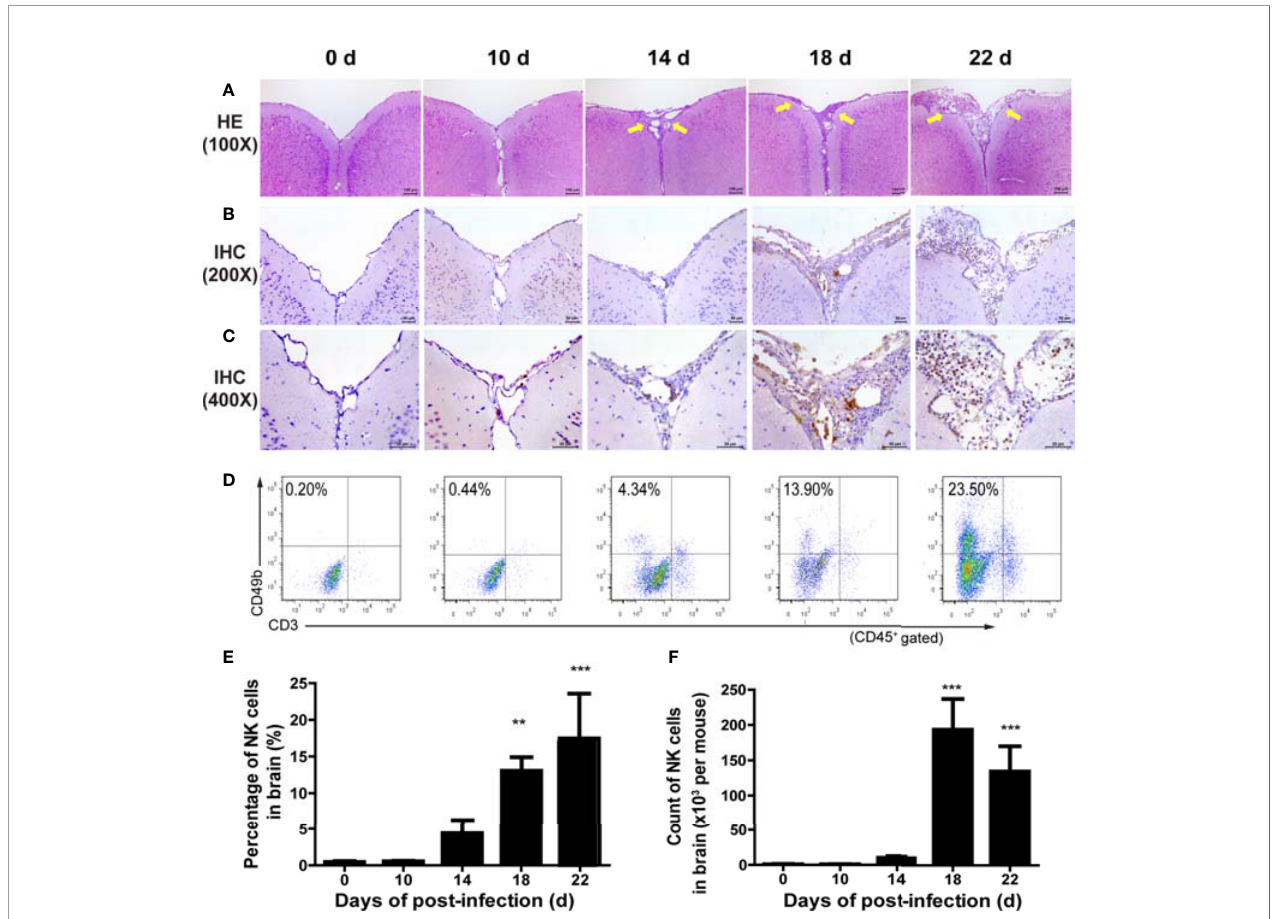
FIGURE 1 | NK cells in fi ltrated into the CNS after A. cantonensis infection. (A) Representative histopathological sections of brain tissue in infected mice with H&E staining. The meninges of infected mice were damaged and in fl ammatory cells in fi ltrated under the meninges (yellow arrow) from 14 to 22 dpi. Images are shown at 100 × magni fi cation (Scale bar, 100 µm). (B, C) Representative histopathological sections of brain tissue in infected mice with IHC staining. Brain sections were incubated with rabbit anti-mouse CD49b monoclonal antibody and stained with DAB. From 14 dpi to 22 dpi, more and more NK cells (stained brown) appeared under the meninges. Images are shown at 200 × and 400×magni fi cation (Scale bar, 100 µm). (D – F) The percentage and absolute number of NK cells in brain mononuclear cells of infected mice. NK cells in brain mononuclear cells were detected by FCM. Data shown represent analysis from two independent experiments with three mice per group. Signi fi cance was determined by one-way ANOVA. ** P < 0.01; *** P < 0.001, compared with that of 0